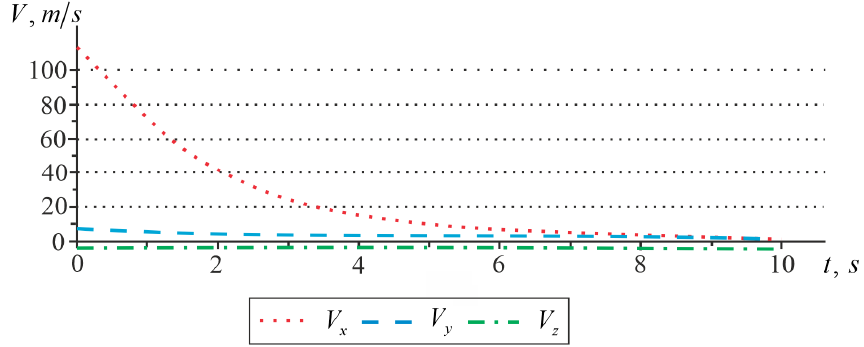
Figure 16. Calculated changes in distances along each of the beams while a helicopter is landing.